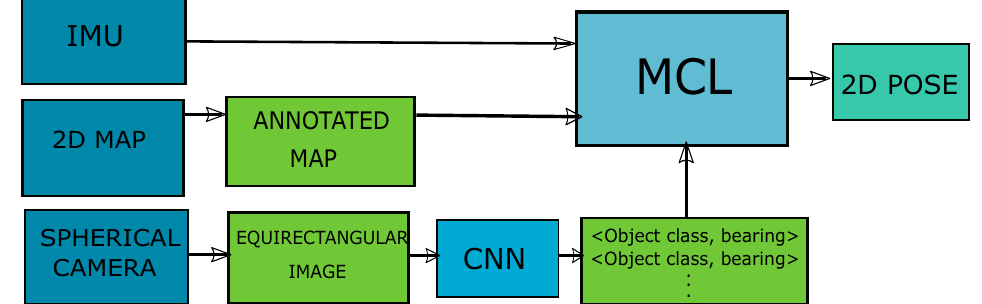
Figure 1. System overview: The proposed localization system using a 2D annotated map, equirectangular images from a spherical camera and an inertial measurement unit (IMU) carried by the user to self-localize. Images are processed using a convolutional neural network (CNN) to obtain the object class and bearing angle to the object center tuple for each